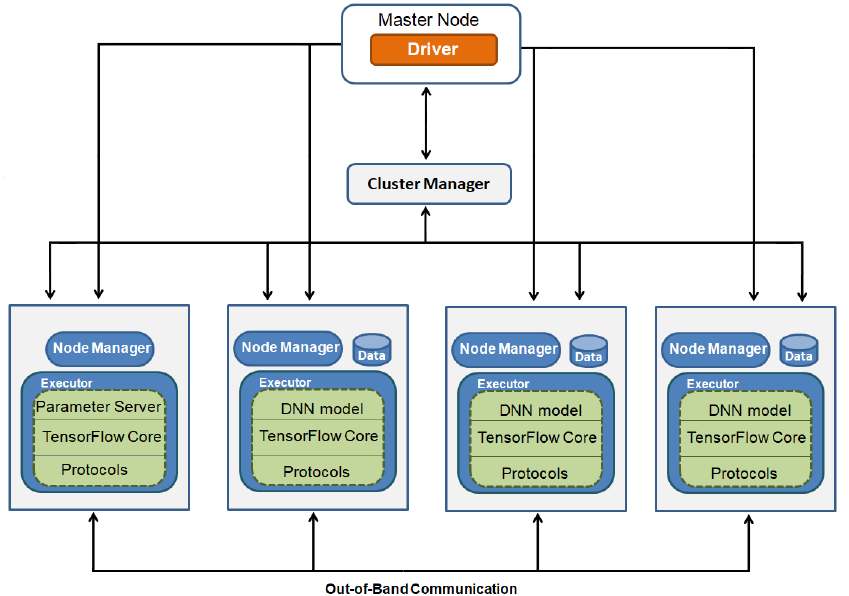
Figure 6. FoS Cluster Setup. The cluster consists of five machines, namely one master node responsible to managing the cluster, one node acting as the parameter server (lower left) and three worker nodes. Each worker node has access to a local version of the dataset, and a executer which implements the training/inference of the DNN. The Parameters does not access data, and is tasked with organising the training/inference